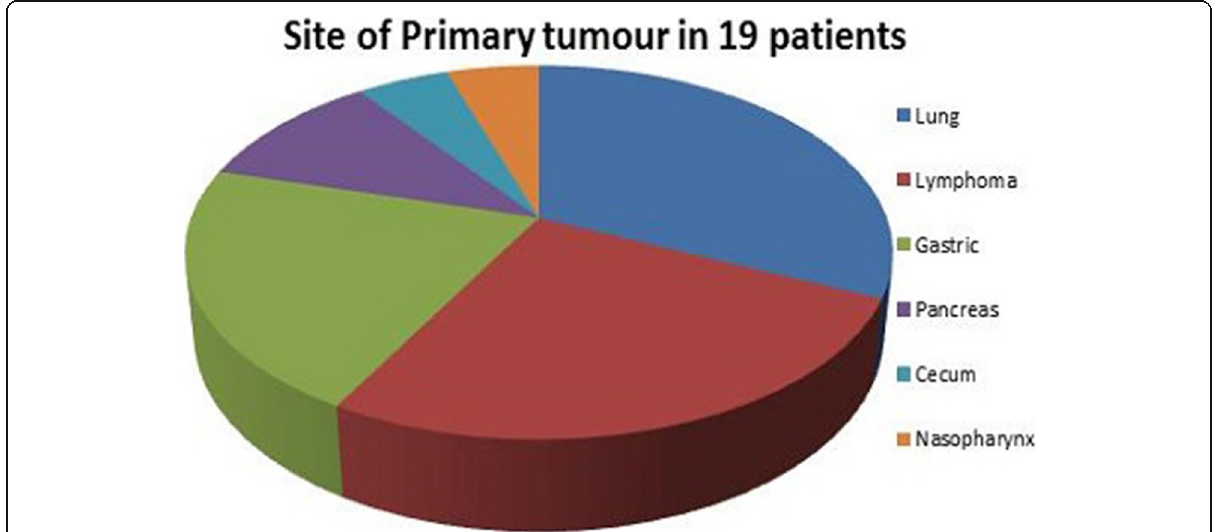
Fig. 1 Pie chart presenting the primary tumor sites in 19 patients with brain